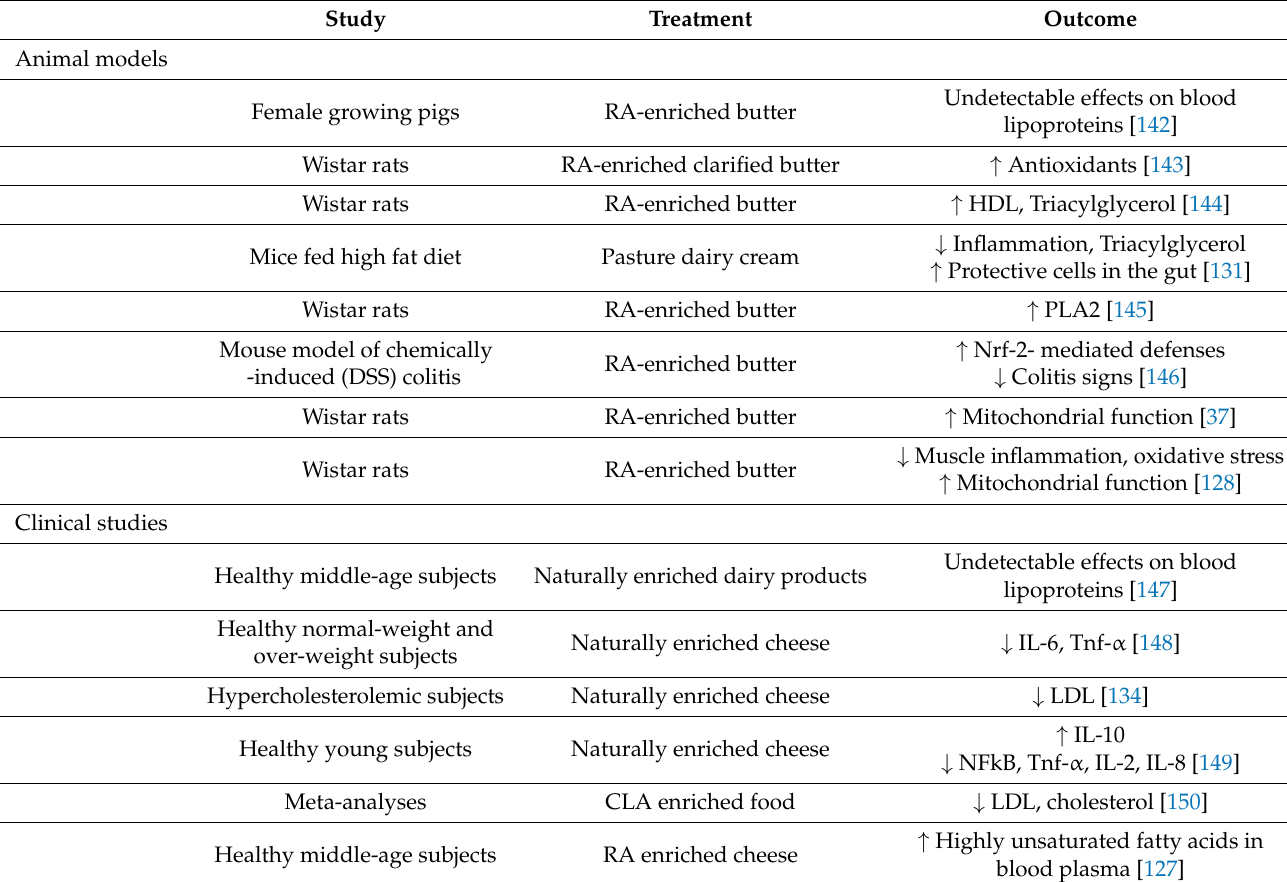
Table 2. Summary of the main studies focused on the biological effects produced by the intake of RA-rich dairy products (data from